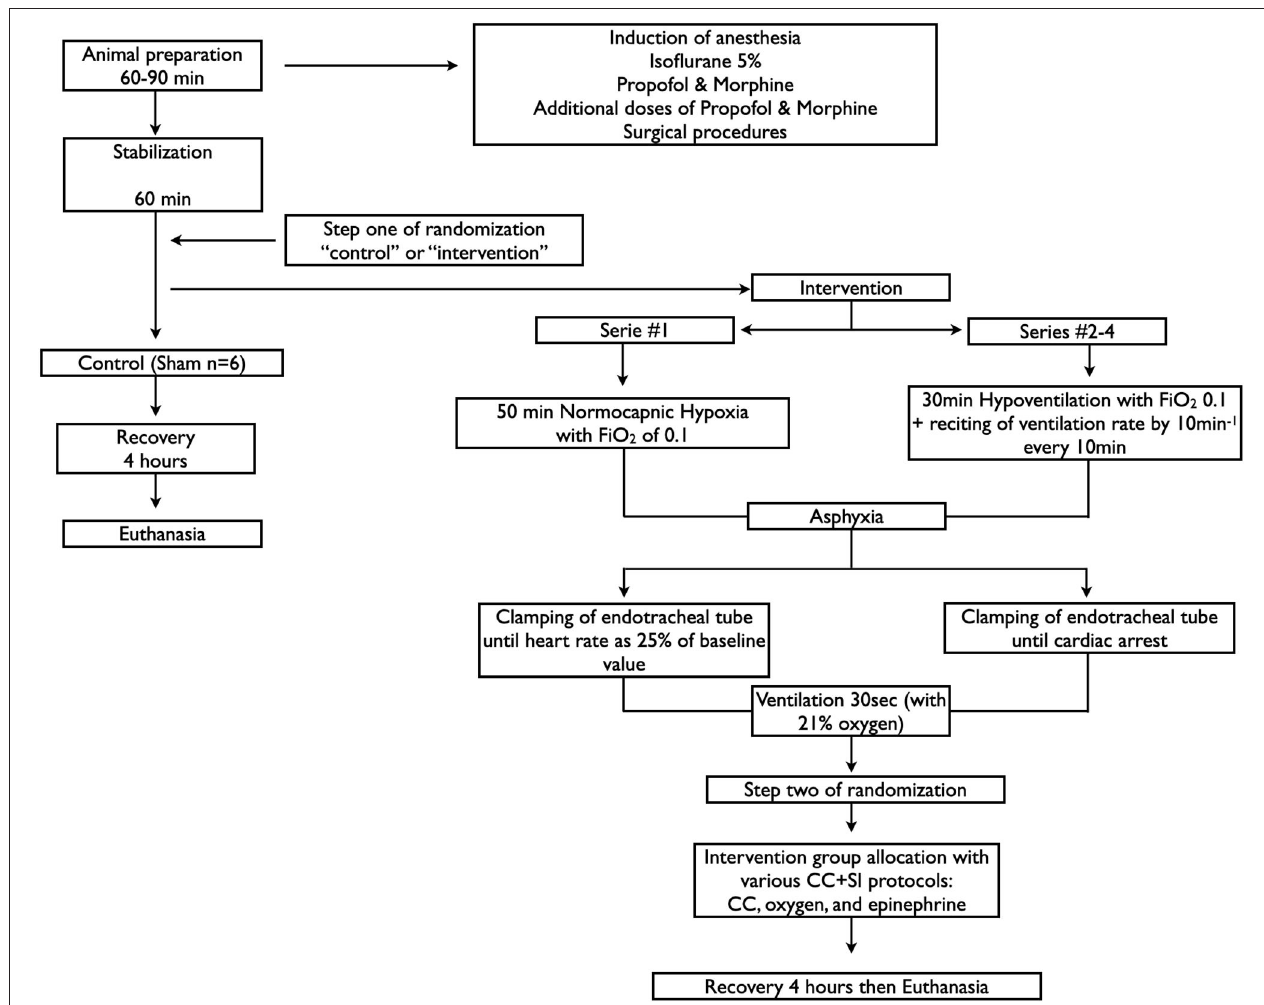
FIGURE 1 | Study flow